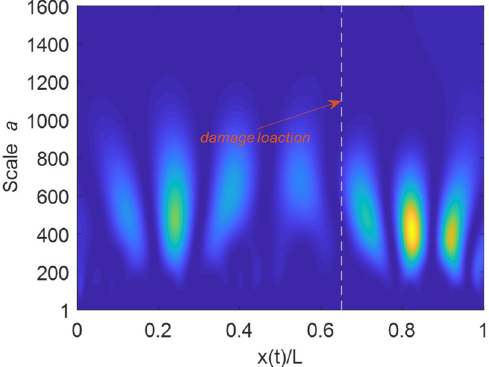
Figure 9. Wavelet scalogram on the acceleration under damaged conditions.